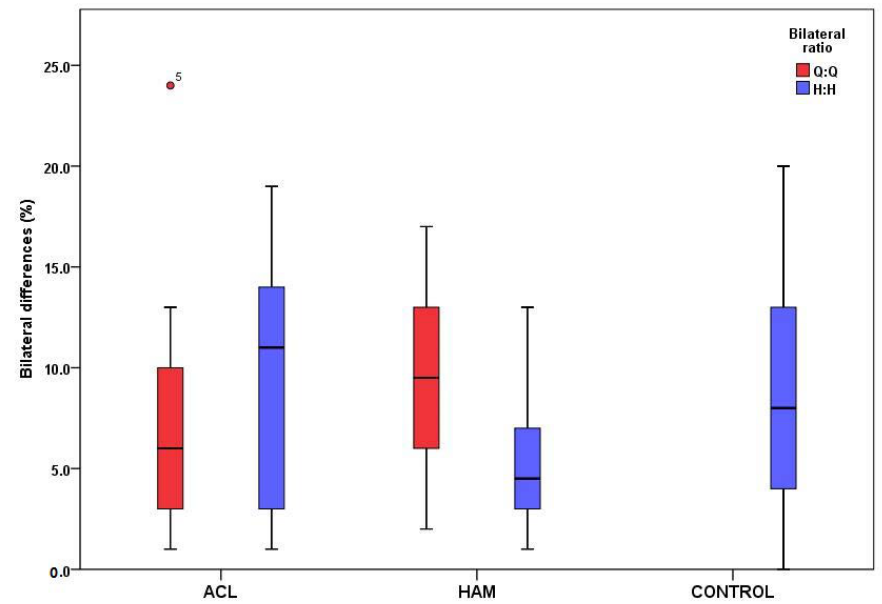
Figure 3. Comparison of bilateral differences between observed groups. Note: ACL = anterior cruciate ligament group, HAM = hamstring group, and CONTROL = control group. Table 3. Effect of observed factors on the bilateral strength ratio.